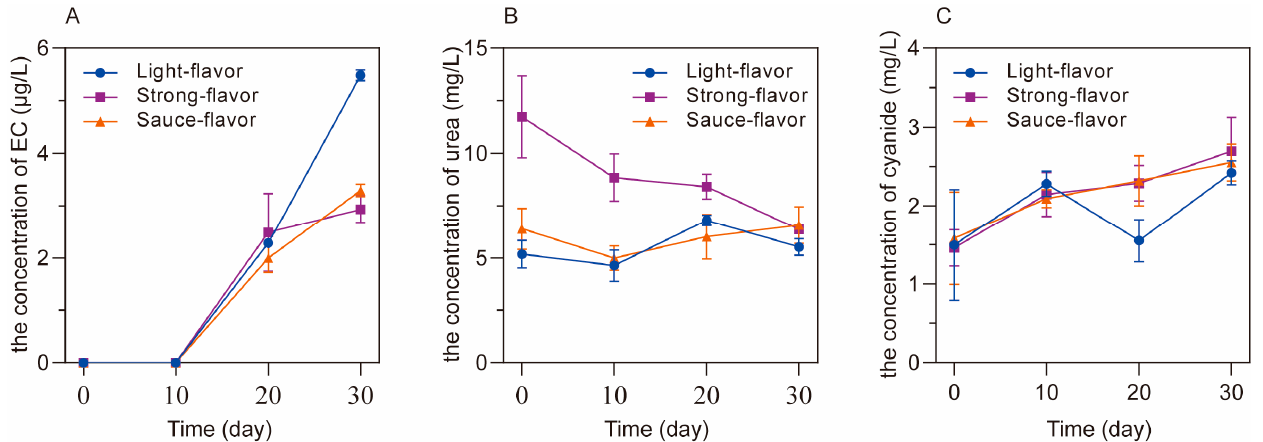
Figure 2. The concentration of EC ( A ), urea ( B ) and cyanide ( C ) during the simulated solid-state fermentation of light- ( ● ), strong- ( ■ ) and sauce-flavor ( ▲ )